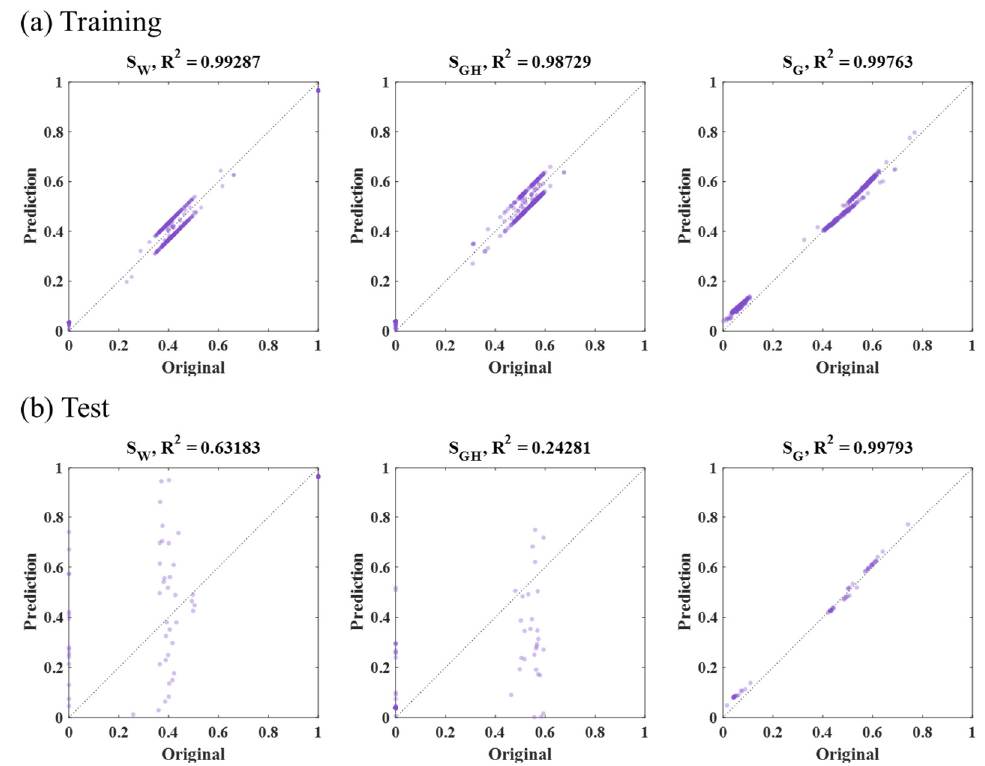
Figure 15. The training ( a ) and test ( b ) results from the CNN with the 1-D vertical input data (Figure 8d).